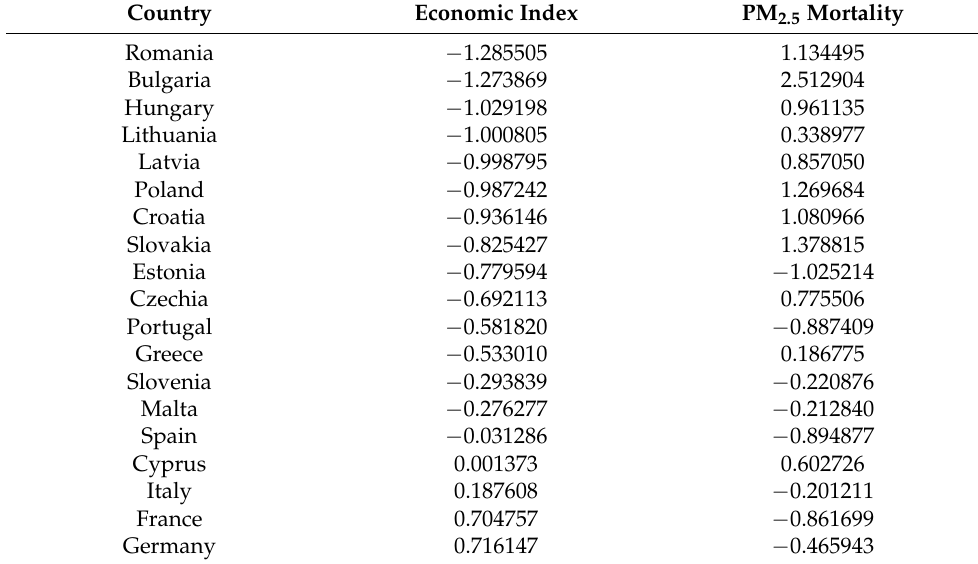
Table 6. The environmental Kuznets curve for the PCA-generated composite economic